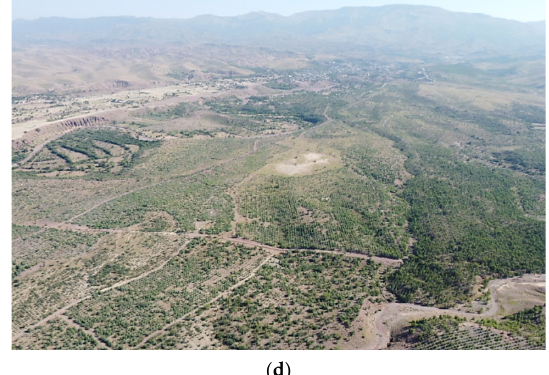
Figure 7. Real images acquired by UAV for ground data samples ( a ) sample 1 ( b ) sample 2 ( c ) sample 3 ( d ) sample 4.